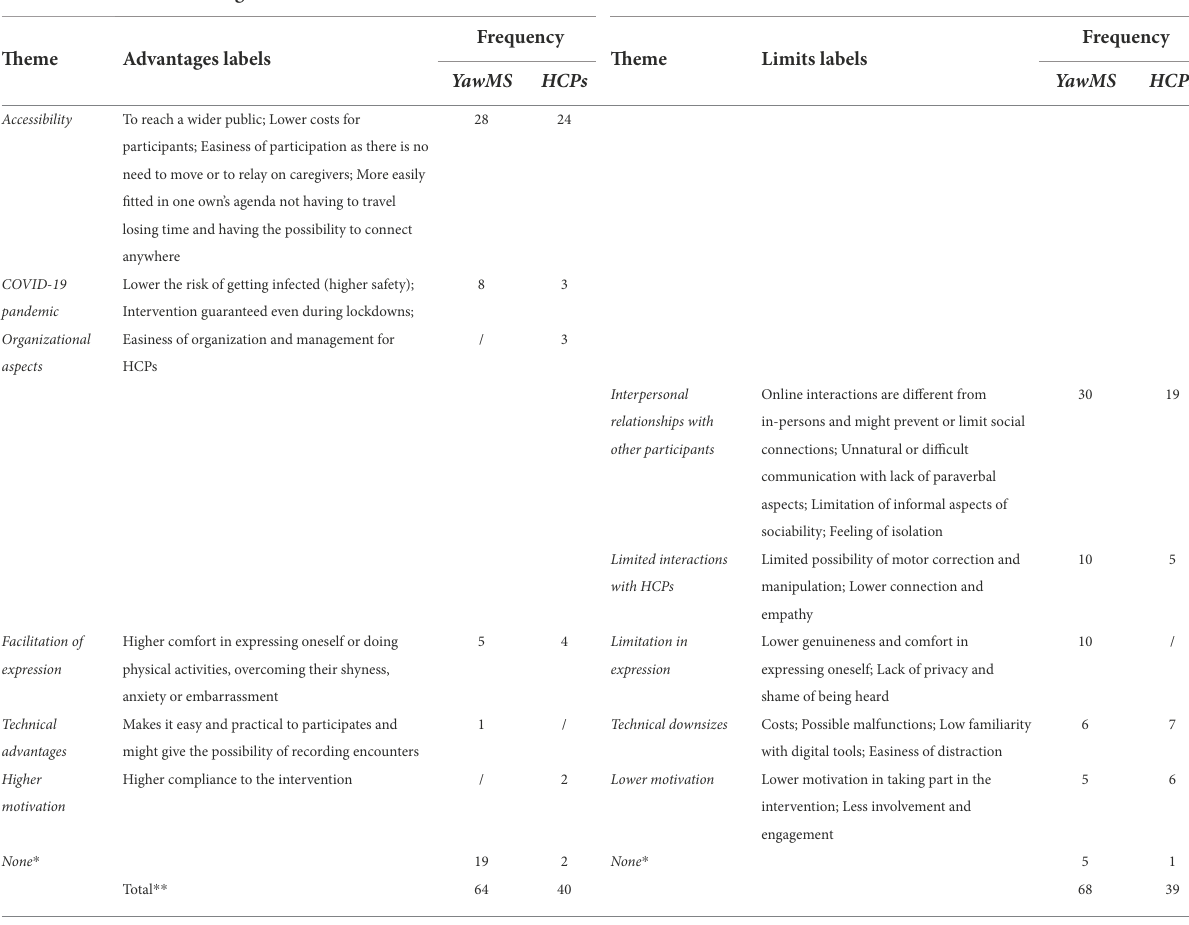
TABLE 4 Survey with YawMS ( N = 121) and with HCPs ( N = 43): qualitative analysis of answer regarding limits and advantages of conducting the intervention through online modalities.